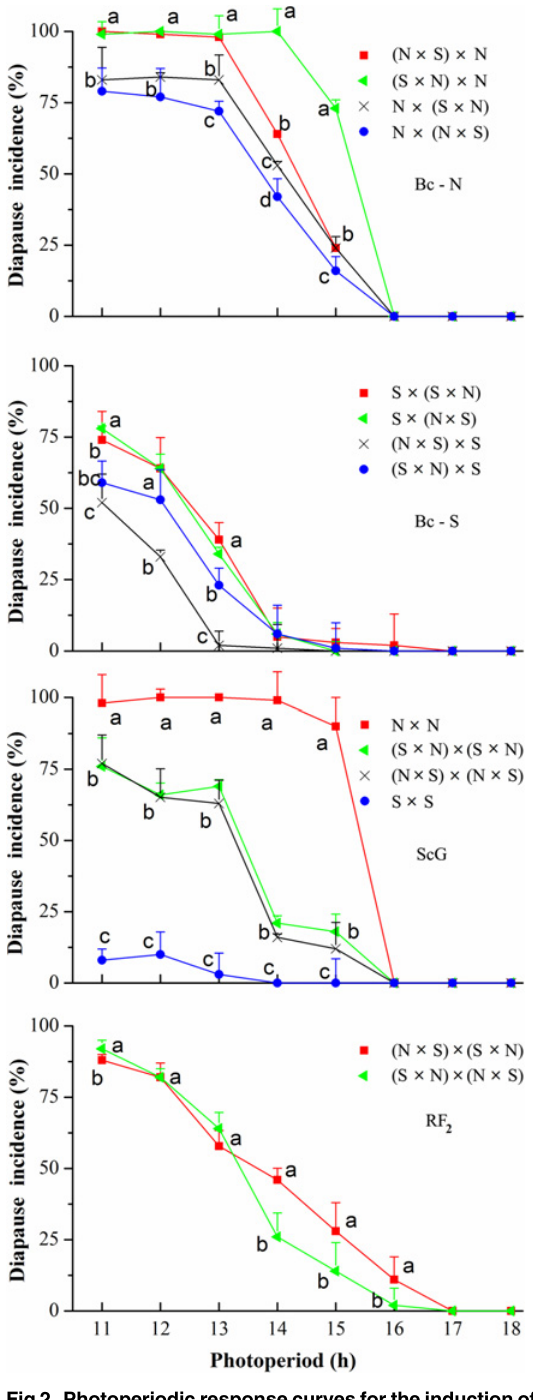
Fig 2. Photoperiodic response curves for the induction of larval diapause at 25°C in Ostrinia furnacalis for the backcross northernmost group (Bc-N), backcross southernmost group (Bc-S), the self-cross group (ScG) and the reciprocal F 2 group (RF 2 ) (n = 76 – 385). Error bars indicate the SD. Bars with different lowercase letters at the same photoperiod indicate significant differences in diapause incidence after one-way analysis of variance ( P < 0. 05). Females show on the left for all the back-cross groups, self- cross group and reciprocal F 2 group.